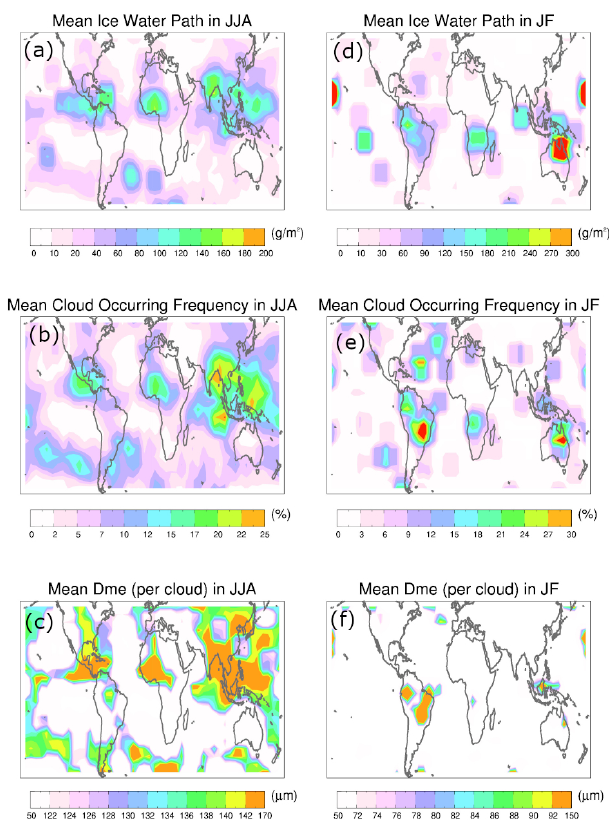
Figure 10. Global distribution (55 ◦ S–55 ◦ N) of IceCube pIWP (a, d) , cloud occurrence frequency (b, e) and cloud mean D me (c, f) for June–July–August 2017 and 2018 (a, b, c) and January–February 2018 (d, e, f) . Grid box size is 5 ◦ latitude × 7.5 ◦ longitude.